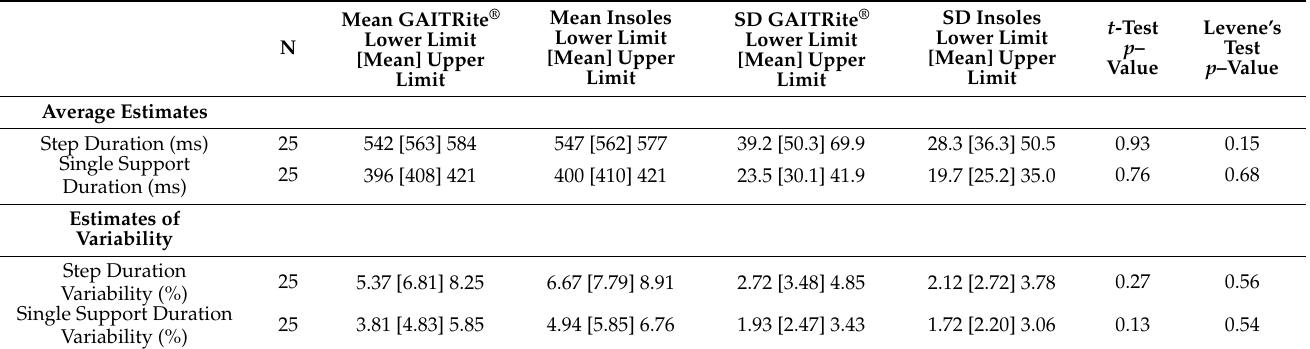
Table 4. Values of average estimates and estimates of variability for the bipedal gait parameters with the following statistics: sample size (N), mean and standard deviations (SD) with GAITRite ® , mean and standard deviations (SD) with insoles and p -values of t -test with independent samples and Levene’s test between GAITRite ® and the insoles.